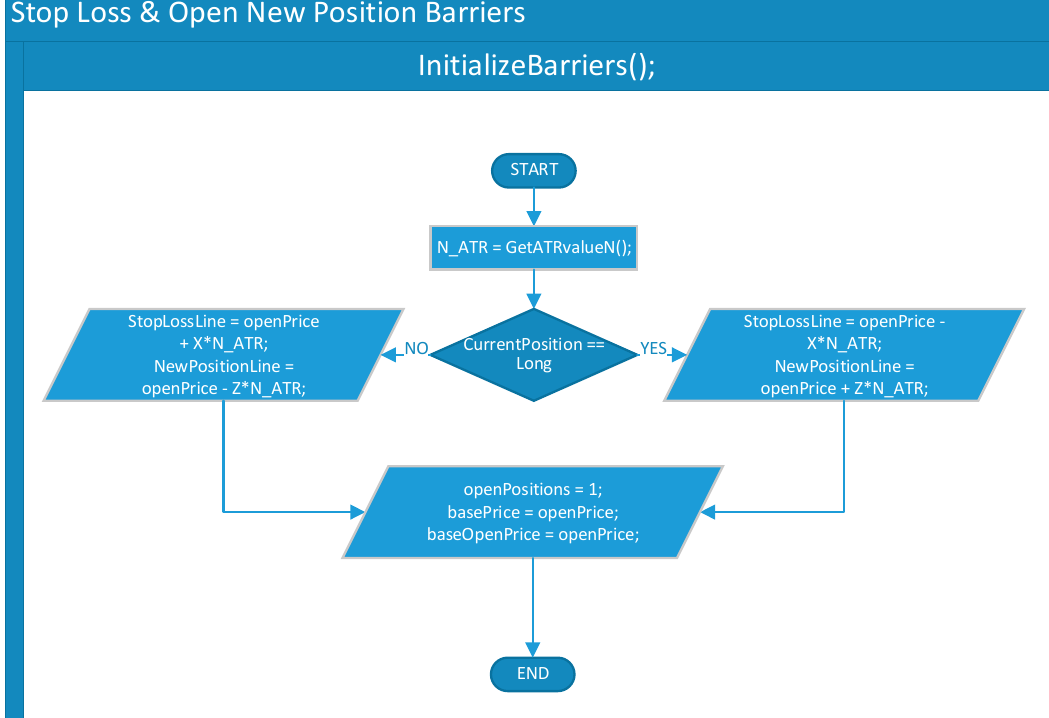
Figure 4. Initialization process after opening the first position. N_ATR is the ATR value at the time the position is opened, X is a constant adjusting the width of the stop loss zone and Z is a constant adjusting the width of the new position zone at which the trading strategy adds to the initial position.